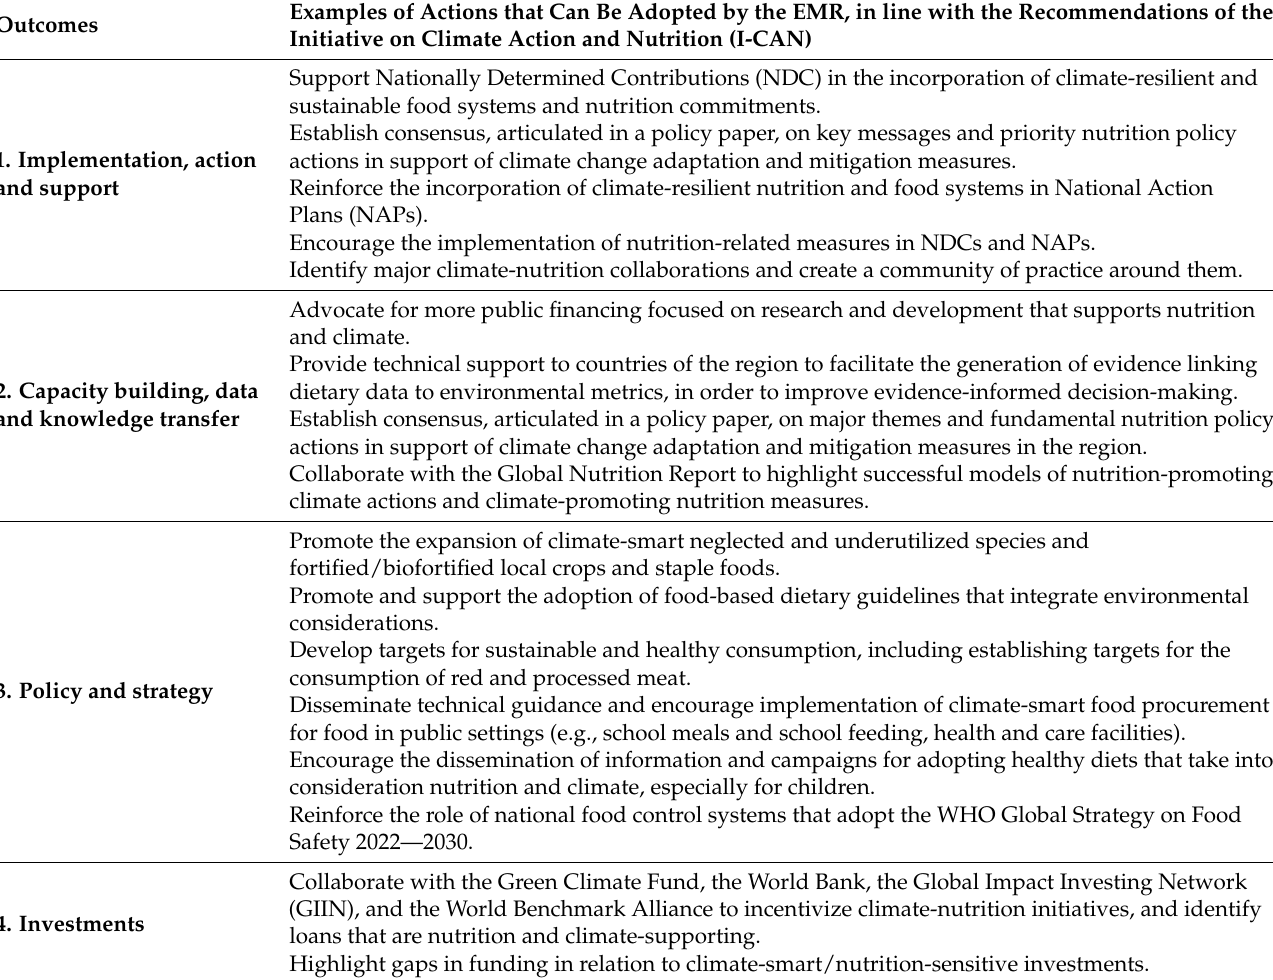
Table 4. Outcomes and examples of action recommended by I-CAN. Adapted from I-CAN